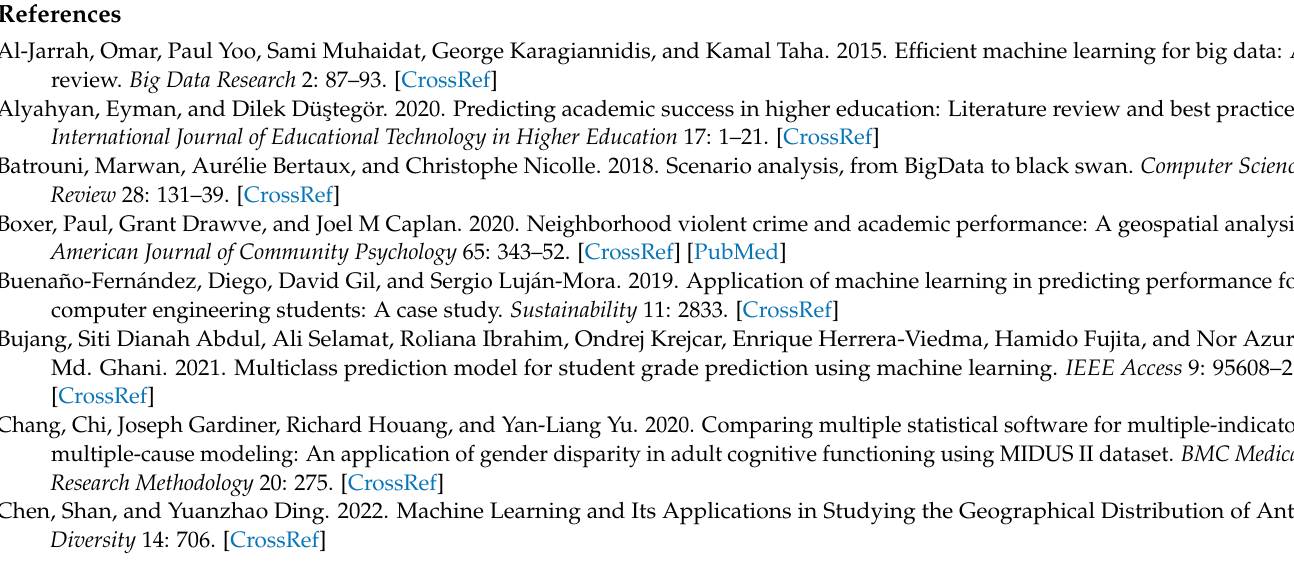
factors; Figure S2: The correlation matrix of the samples; Table S1: Coding for machine learning and data analysis (Python); Table S2: Coding for feature importance (Python); Table S3: Coding for PA heatmap (R, Population, × 10,000); Table S4: Coding for PA heatmap (R, Total Offenses, × 1000); Table S5: Coding for PA heatmap (R, Real); Table S6. Coding for PA heatmap (R, Prediction); Table S7. Coding for PA heatmap (R, CrimeRate); Table S8. Tuning results by random search. Author Contributions: Conceptualization, S.C. and Y.D.; methodology, Y.D.; software, Y.D.;